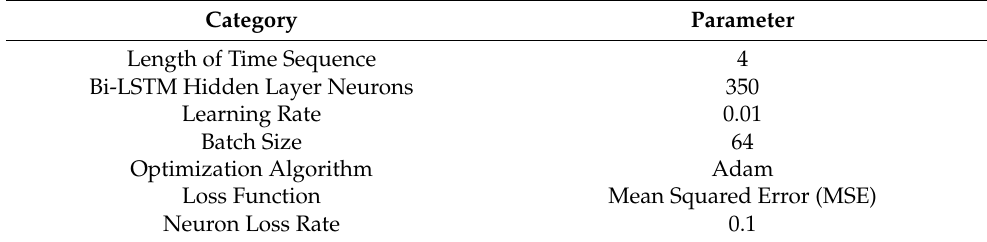
Table 5. Related parameters of LSTM-based PGPMs. Category